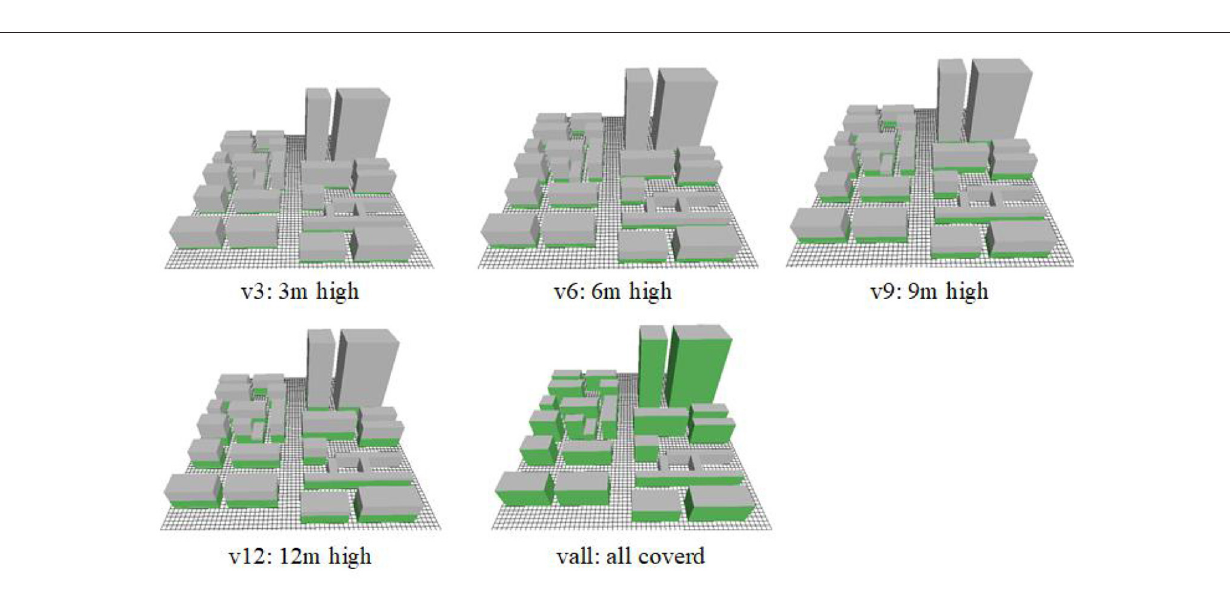
FIGURE 12 | Layouts of different vertical